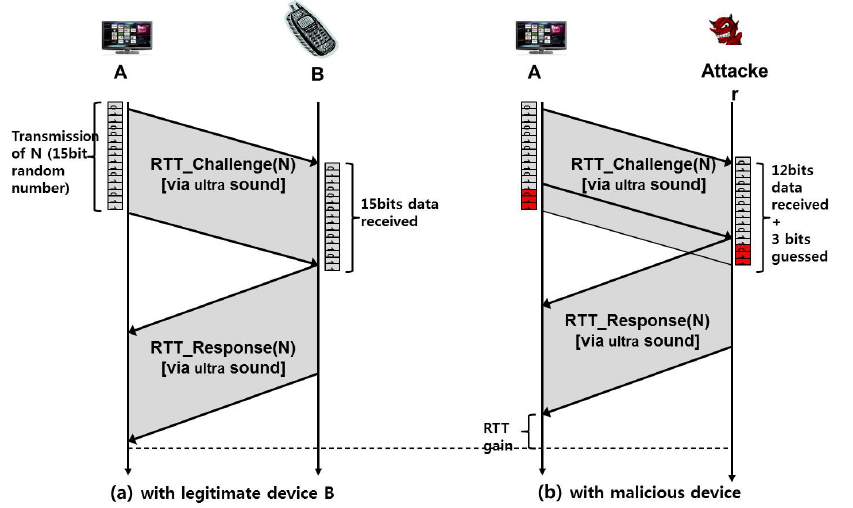
Figure 5. Potential security issue in ultrasound